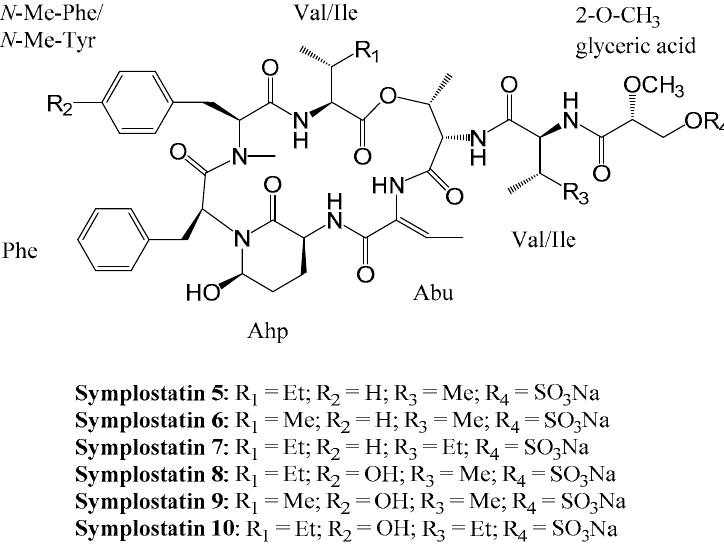
Figure 7. Structures of Symplostatins 5–10.